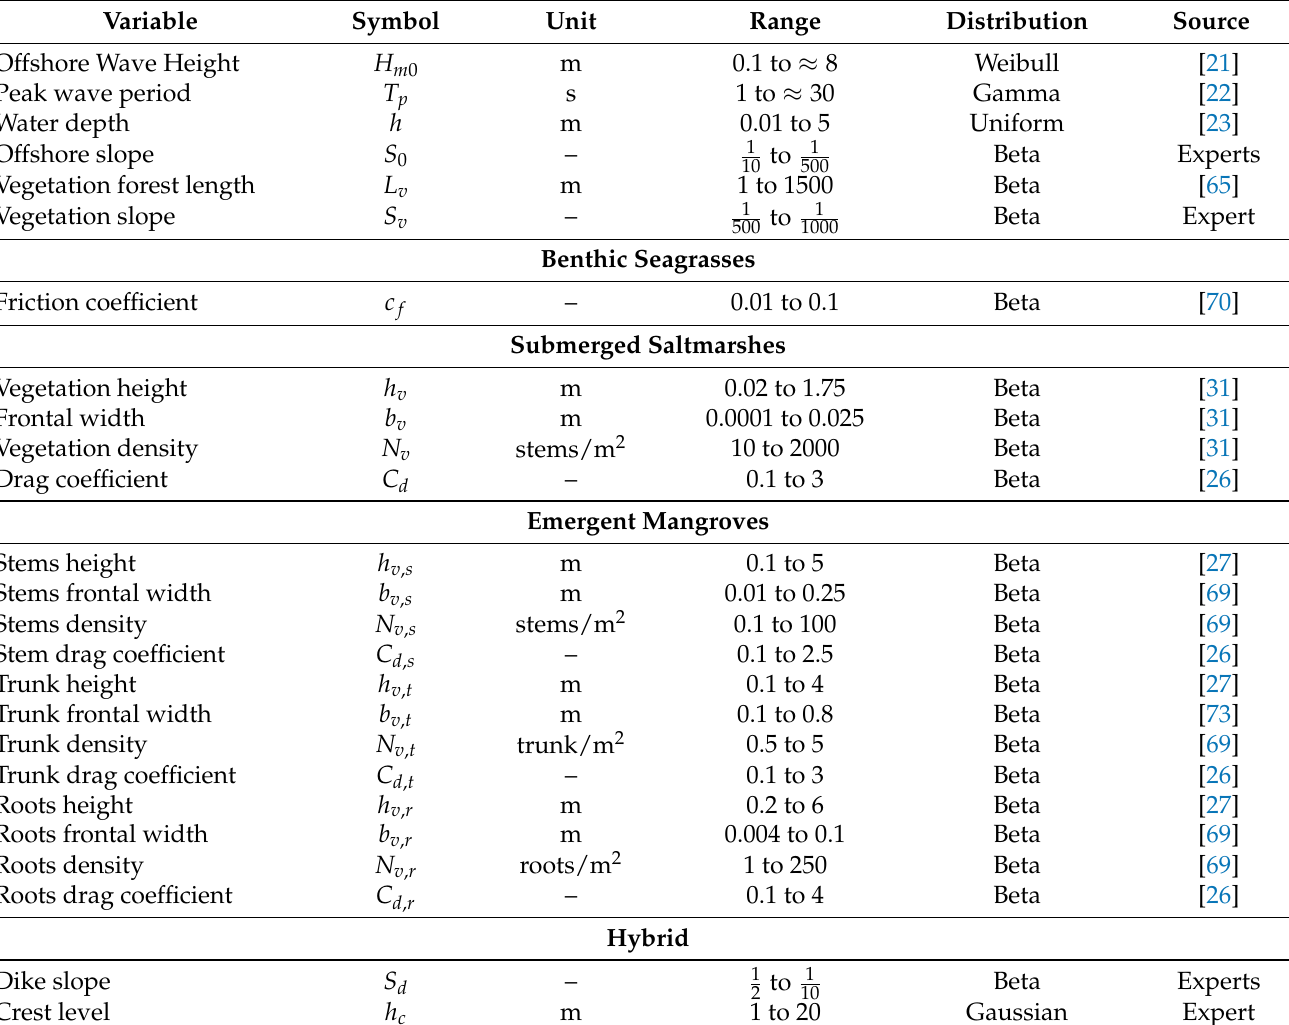
Table 2. Ranges and marginal distributions for variables in the vegetated hydrodynamic system. Refer to Table A1 for complete description of variable